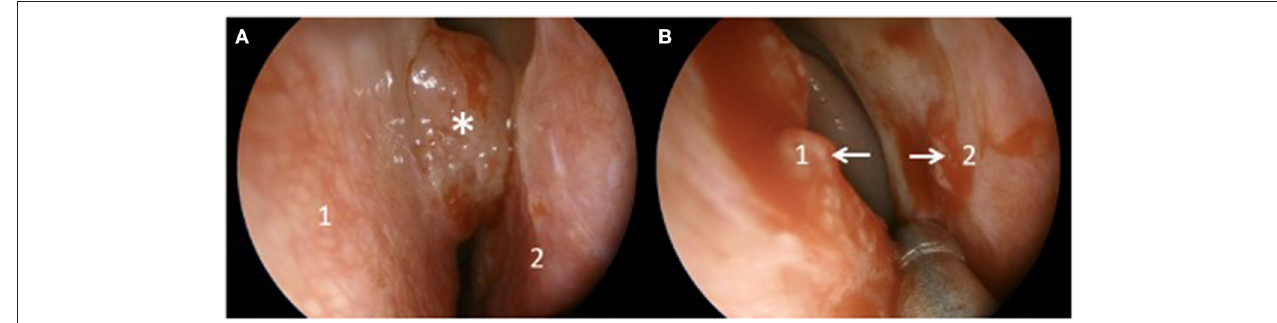
FIGURE 2 | Endoscopic examination before (A) and after (B) tumor debulking.